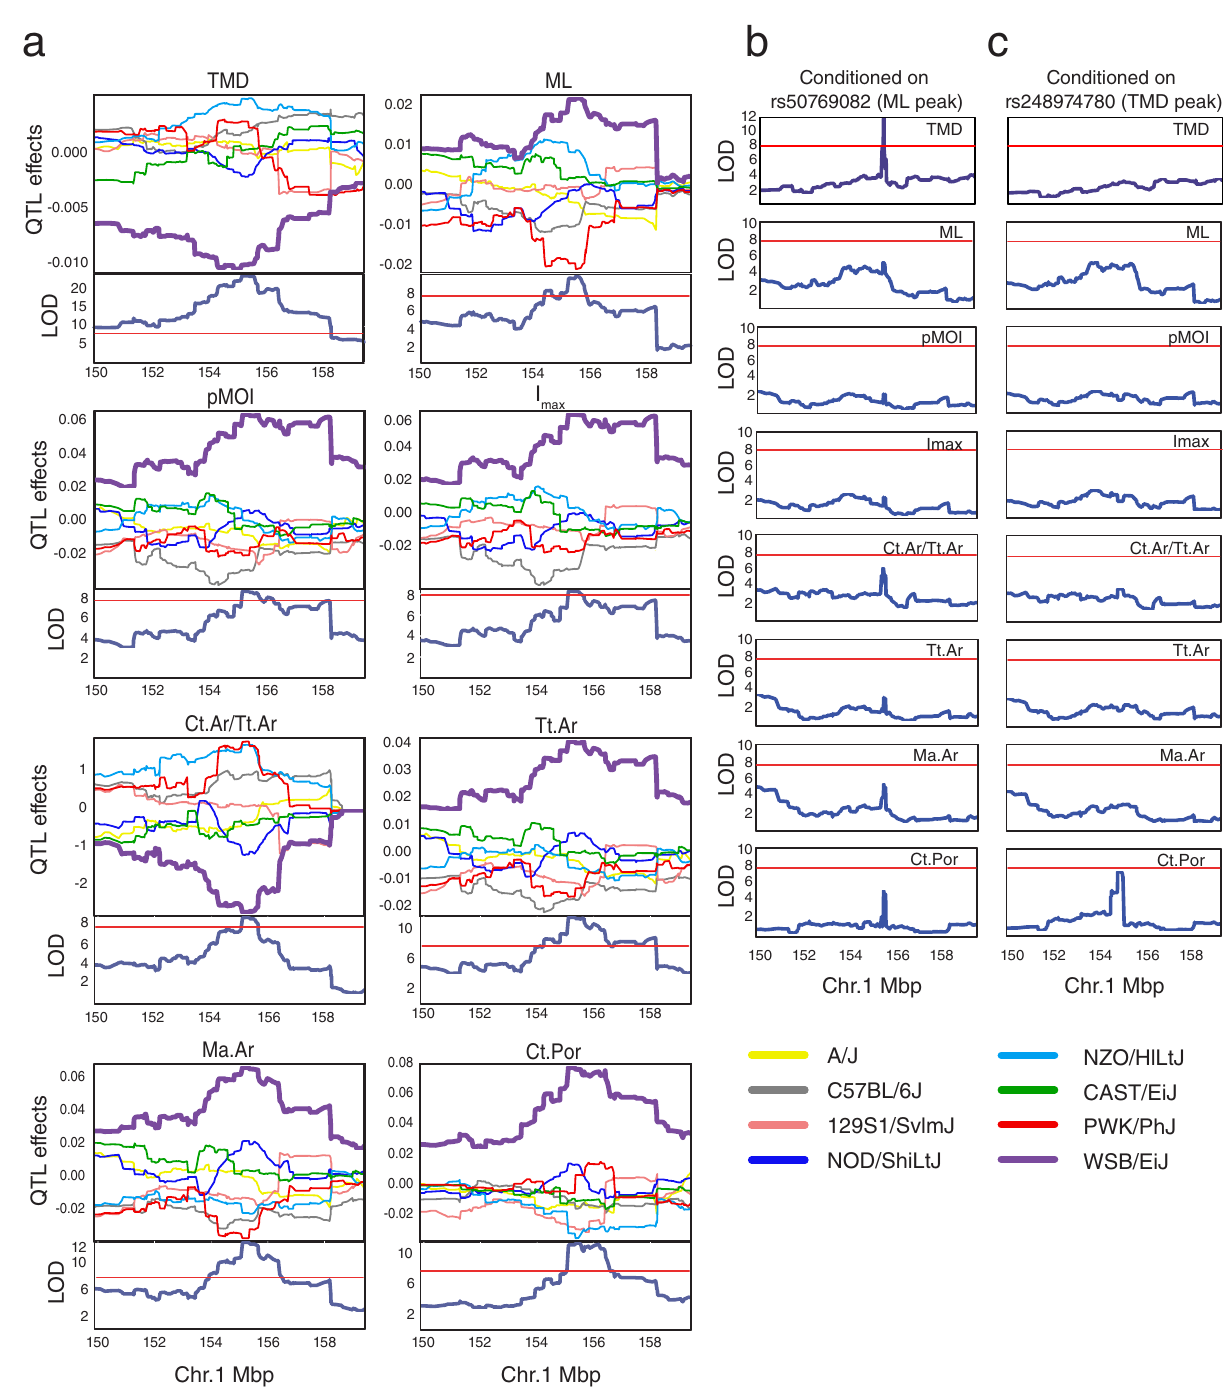
Fig. 6 QTL (locus 1) on chromosome 1. a For each plot, the top panel shows allele effects for the DO founders for each of the eight QTL (quantitative trait loci) across an interval on chromosome 1 (Mbp, colors correspond to the founder allele in the legend). Bottom panels show each respective QTL scan. The red horizontal lines represent LOD (logarithm of the odds) score thresholds (genome-wide P < = 0.05). Colors indicate founder mouse strains: A/J (yellow), C57BL/6J (gray), 129S1/SvImJ (beige), NOD/ShiLtJ (dark blue), NZO/HILtJ (light blue), CAST/EiJ (green), PWK/PhJ (red), and WSB/EiJ (purple). b QTL scans across the same interval as a , after conditioning on rs50769082. c QTL scans after conditioning on rs248974780.